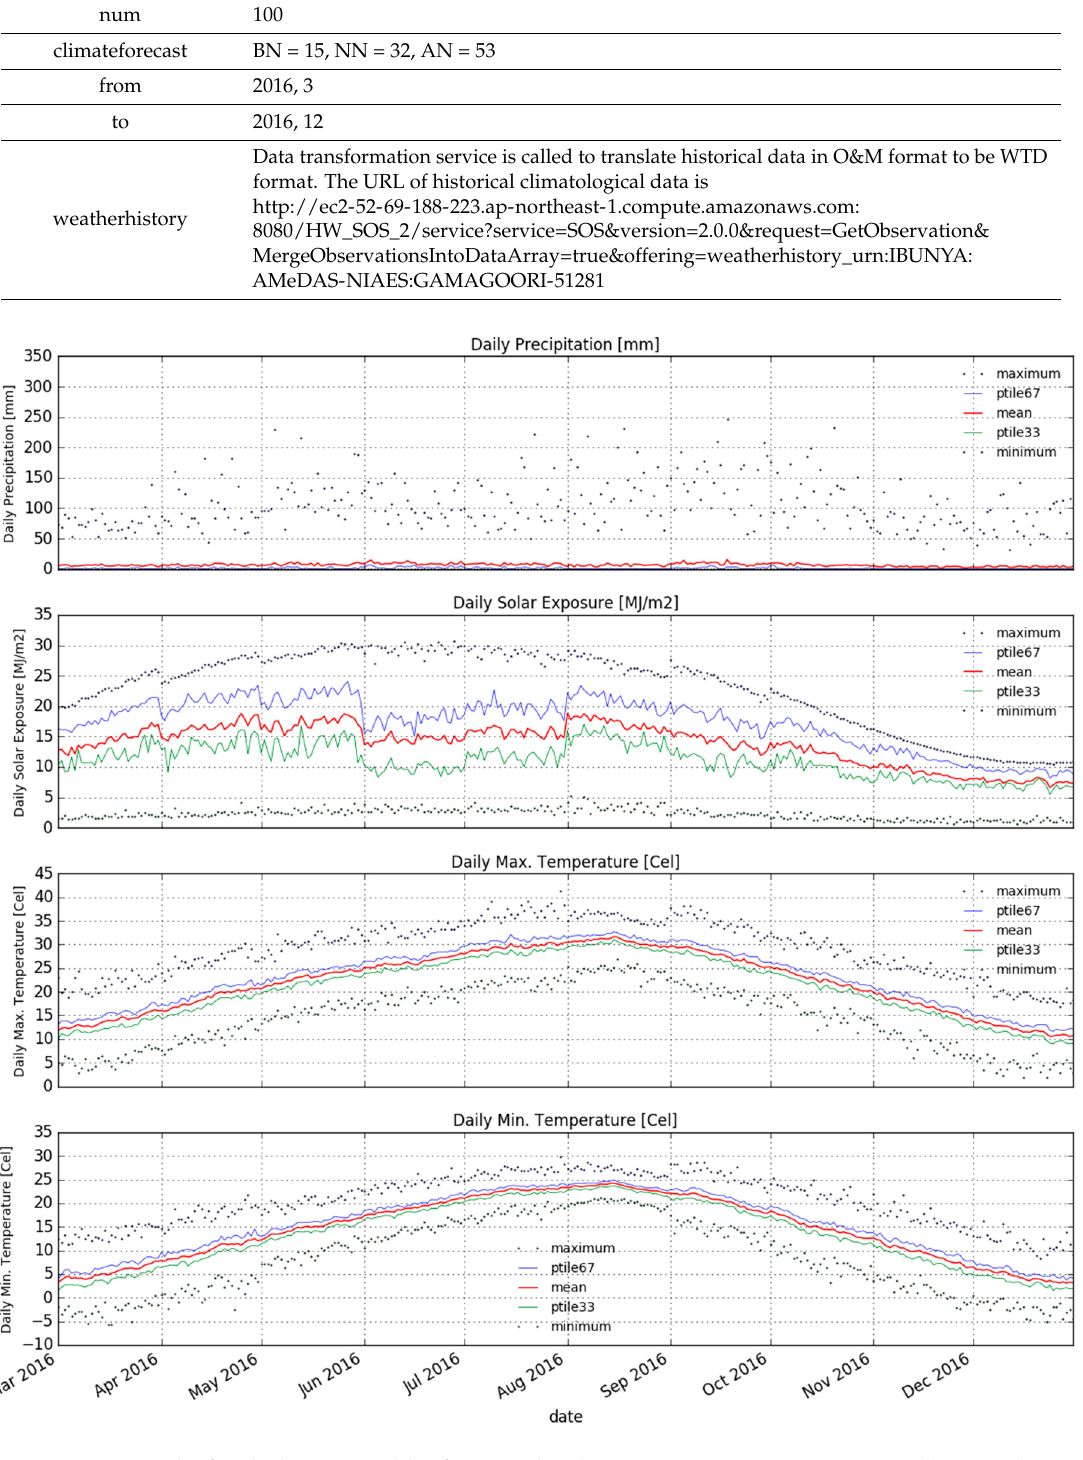
Figure 8. Graph of each climate variable of case study 2 (PDISAGWS, BN = 15, NN = 32, and AN = 53).